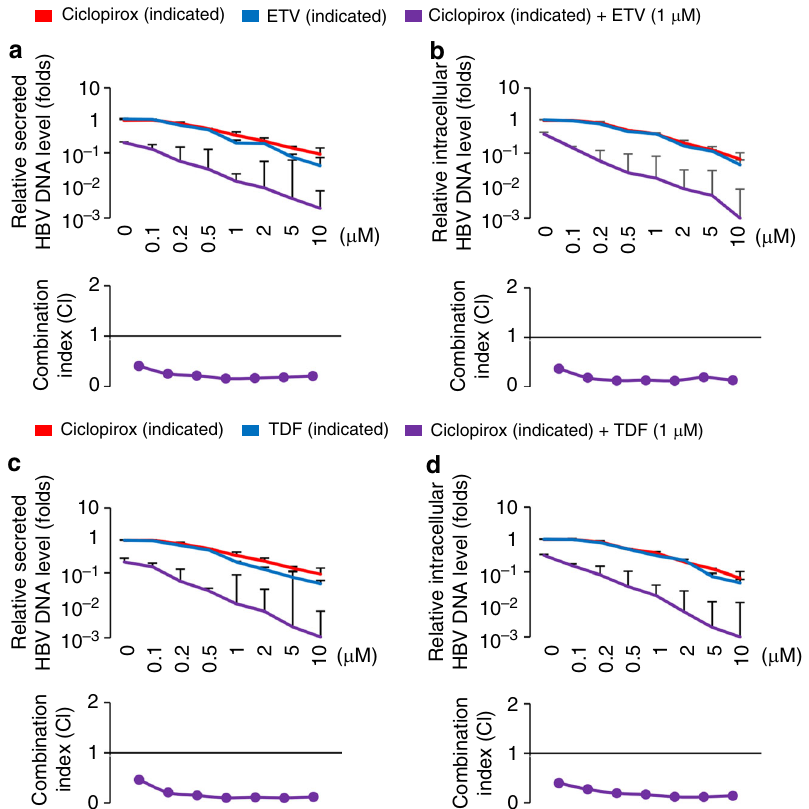
Fig. 6 Effect of combined ciclopirox and TDF and ETV on replication of HepG2.2.15 cells. HepG2.2.15 cells were treated with 1 μ M TDF or ETV and various concentrations (0.1 – 10 μ M) of ciclopirox. a – d Secreted HBV DNA ( a , c , respectively) and intracellular HBV DNA ( b , d , respectively) were measured by quantitative PCR. Combination indices (CI) were analyzed by the Chou-Talalay method. The data in ( a – d ) are representative of three independent experiments and are expressed as mean ± SD. The error bars represent the ± SD. * p < 0.05; ** p < 0.01, by unpaired two-tailed Student ’ s t -tests. Source